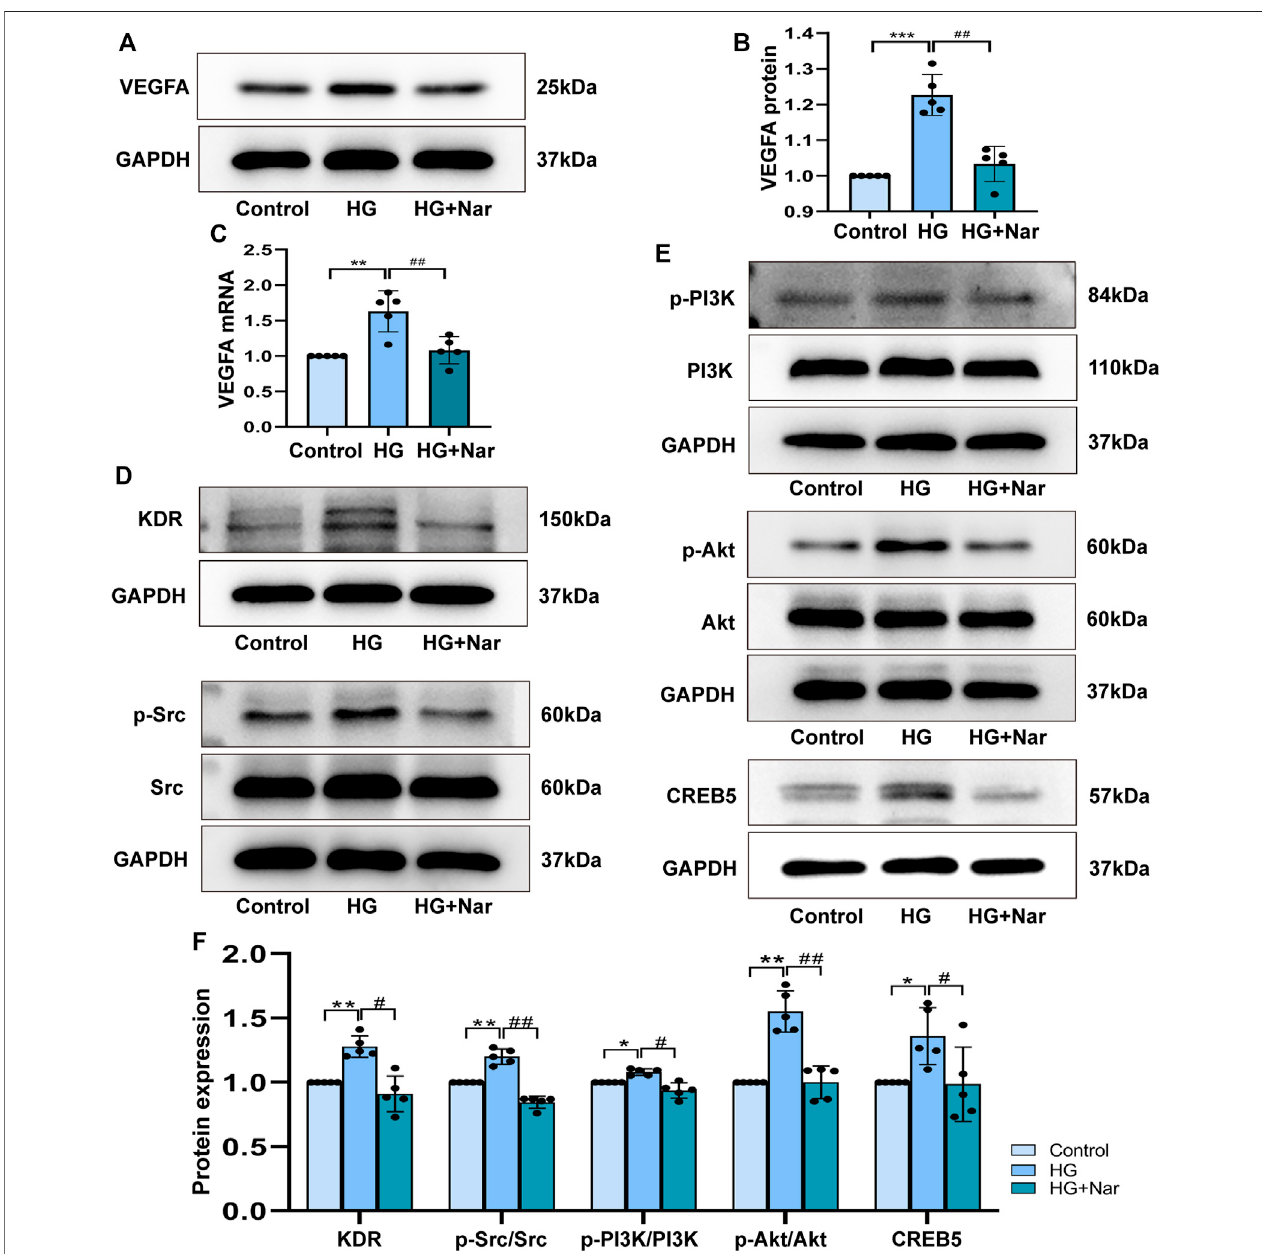
FIGURE9| Nardown-regulatedtheexpressionofcoretargetVEGFAandPI3K/Akt/CREB5signalingpathway. (A) Westernblotdetectedtheproteinexpressionof VEGFA. (B) Analysis of VEGFA protein expression. (C) Analysis of VEGFA mRNA expression. (D,E) Nar suppressed KDR, p-Src, p-PI3K, p-Akt and CREB5 expression which upregulated by HG group. (F) Bar graph showed related protein expression analysis. * p < 0.05, ** p < 0.01 compared with Control group, # p < 0.05, ## p < 0.01 compared with HG group.